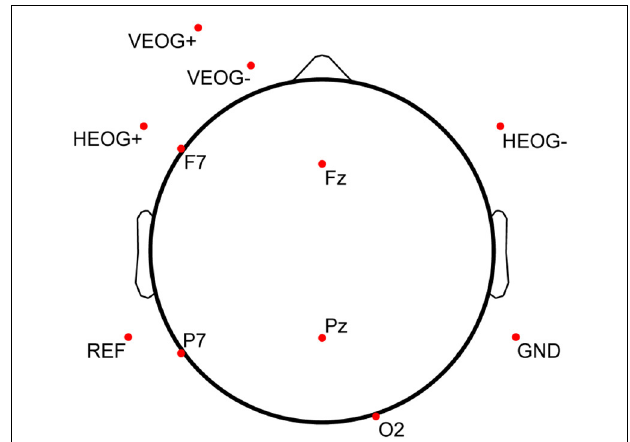
FIGURE 3 | Electrode montage used for electrophysiological data collection. Each of the 11 electrodes shown here was a single-lead, 9mm tin cup electrode. Bipolar lead configuration for ECG [( + ) on left clavicle, ( − ) on sternum] is not shown in this diagram. Electrodes below the horizon of the axial view are shown with a flattened projection